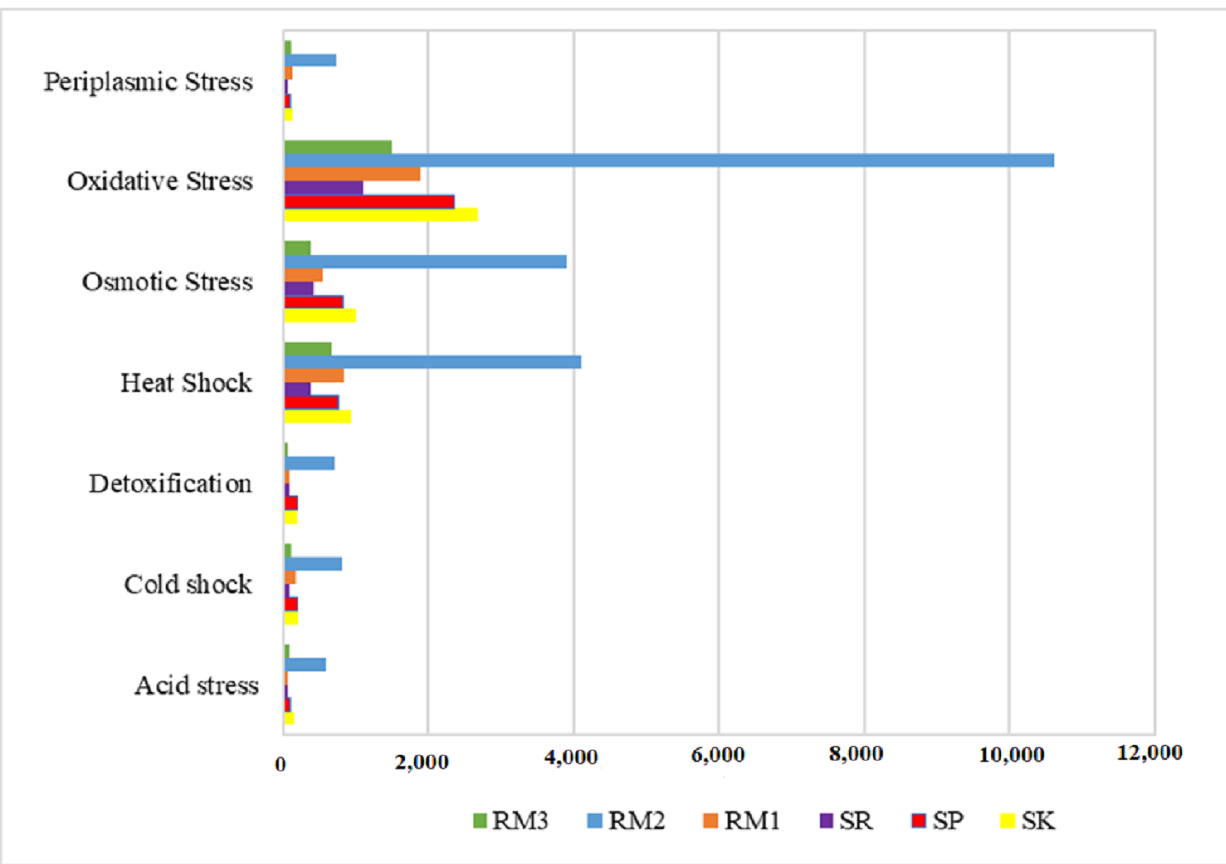
Figure 5. Gene abundances involved in the microbial-degradation pathways of stress response by the WGS Shotgun. Taxonomic assignments for the Royal Belum (SK, SP, and SR) and Raja Muda Musa (RM1, RM2, and RM3) metagenomes were performed using MgRast .